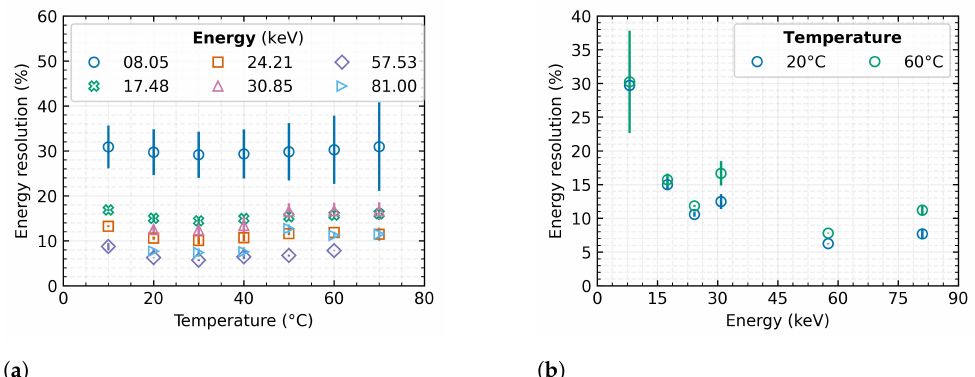
Figure 7. The energy resolution of Timepix3 detector with 500µm Si sensor. The plotted data represent the mean values over the tested detectors, and the error bars indicate their minimum and maximum value. ( a ) dependence on detector temperature; ( b ) dependence on radiation energy.